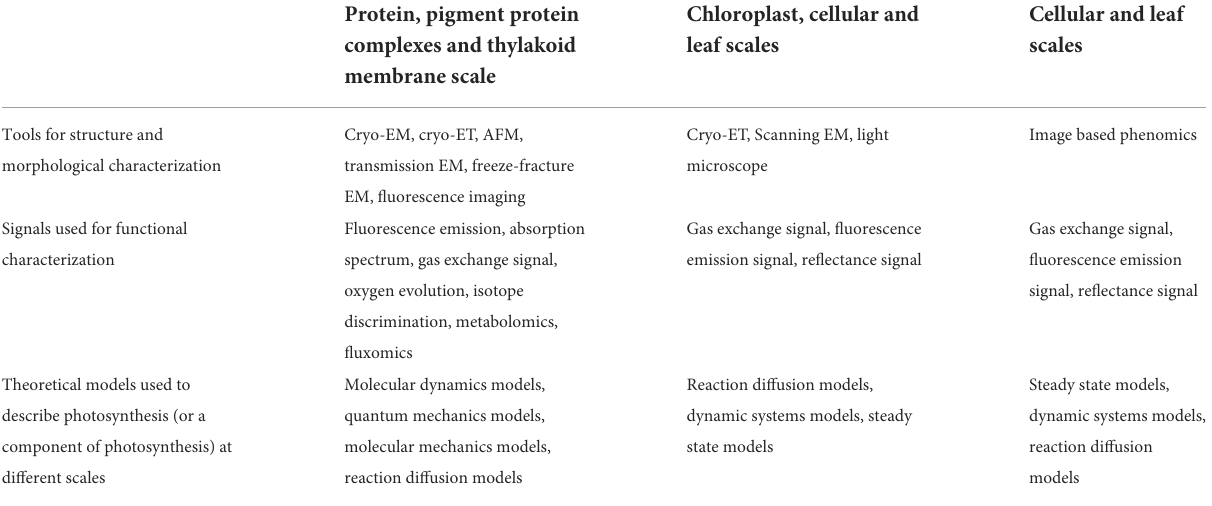
TABLE 1 Methods used to study photosynthesis at different